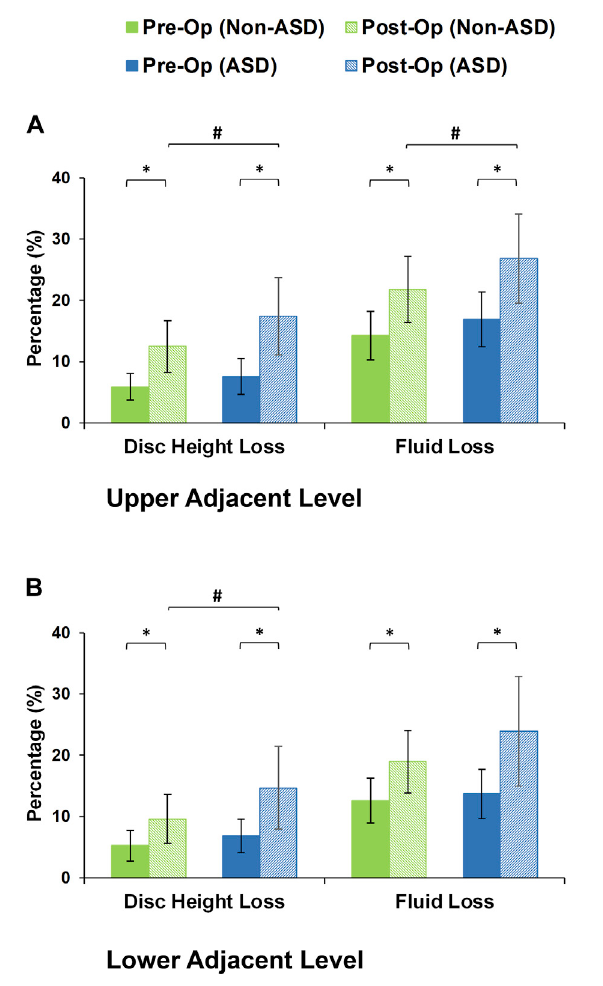
FIGURE 6 Calculated facet joint forces for non-ASD and ASD group FE models in the (A) upper and (B) lower adjacent level for different directions.